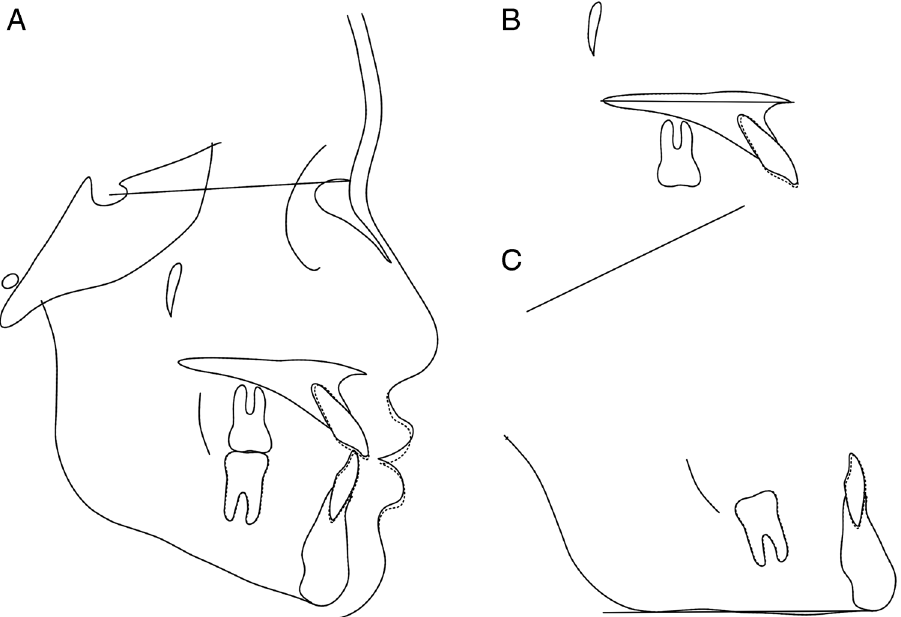
Figure 15. Superimposition of the cephalometric tracings obtained at posttreatment (solid line) and postretention (dotted line). (A) The sella-nasion plane at the sella. (B) The palatal plane at the ANS. (C) The mandibular plane at the